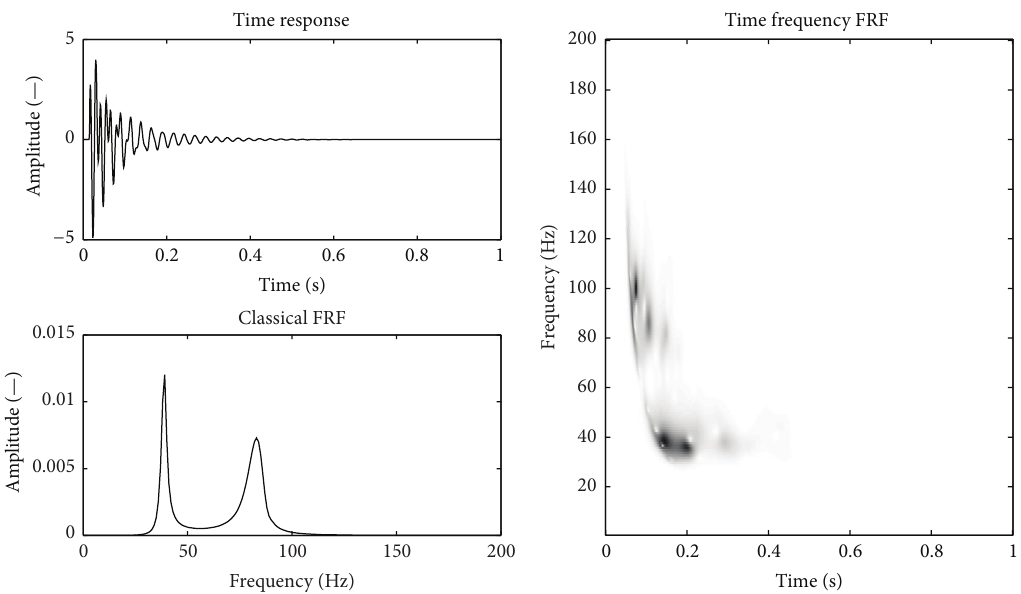
Figure 7: Simulated results obtained for the impact excitation in the time, frequency, and combined time-frequency domains.